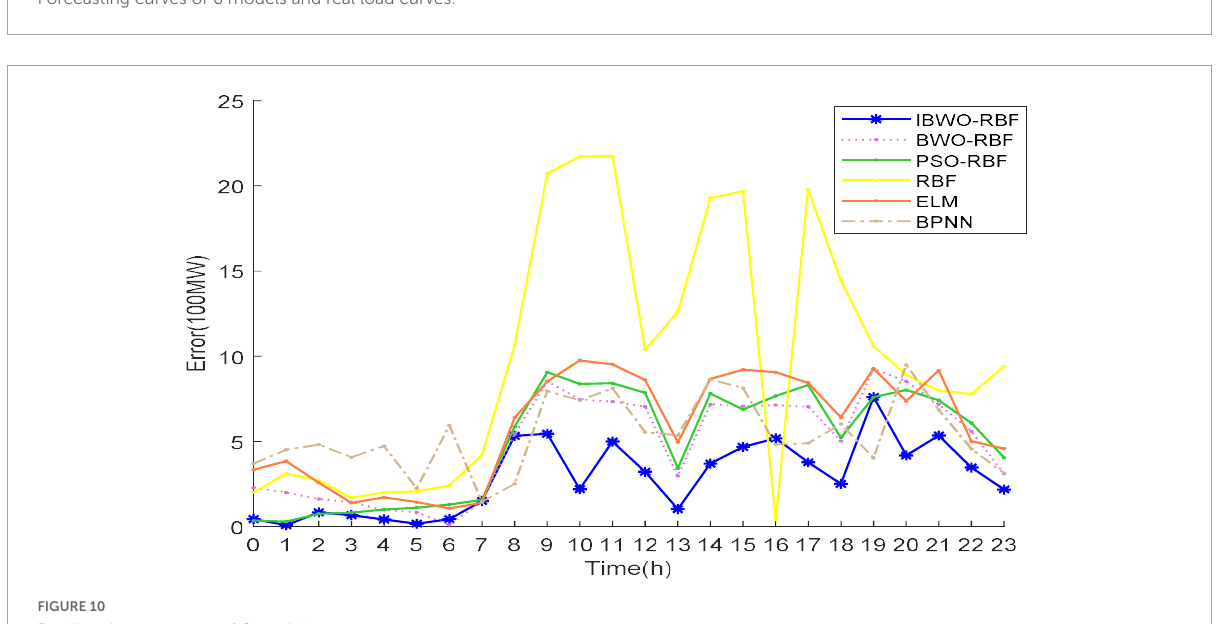
FIGURE9 Forecasting curves of 6 models and real load curves.